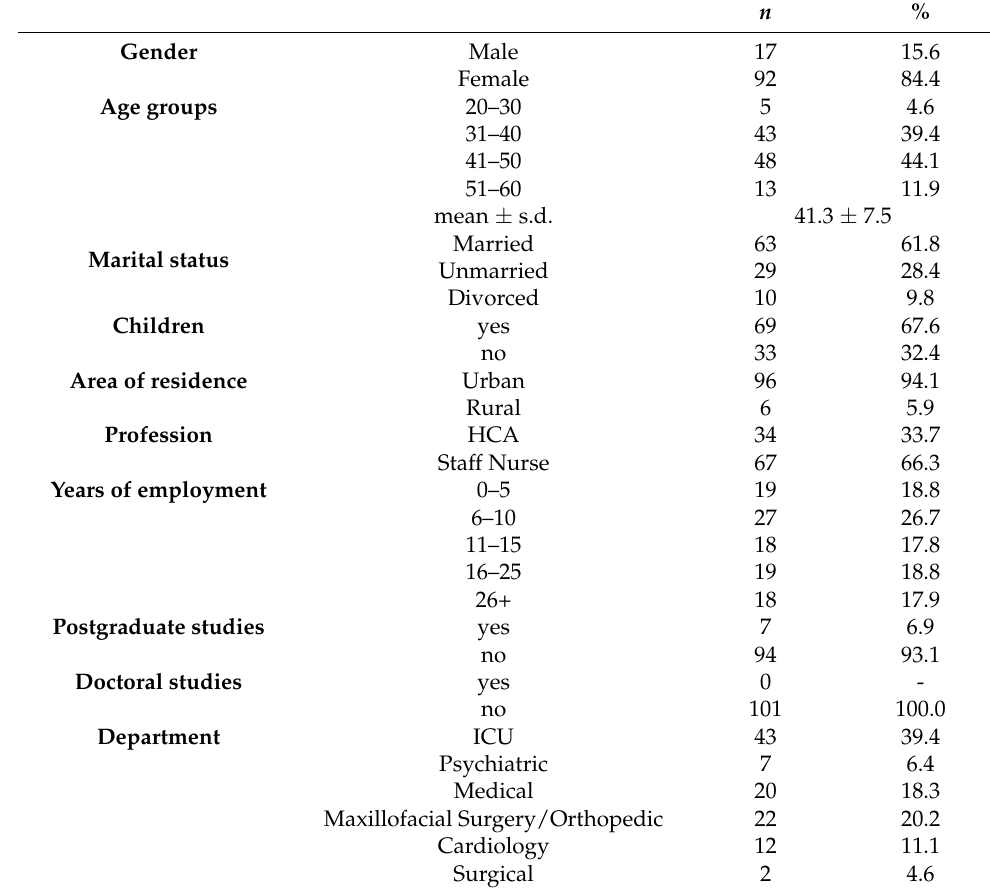
Table 1. Descriptive characteristics of the study participants.